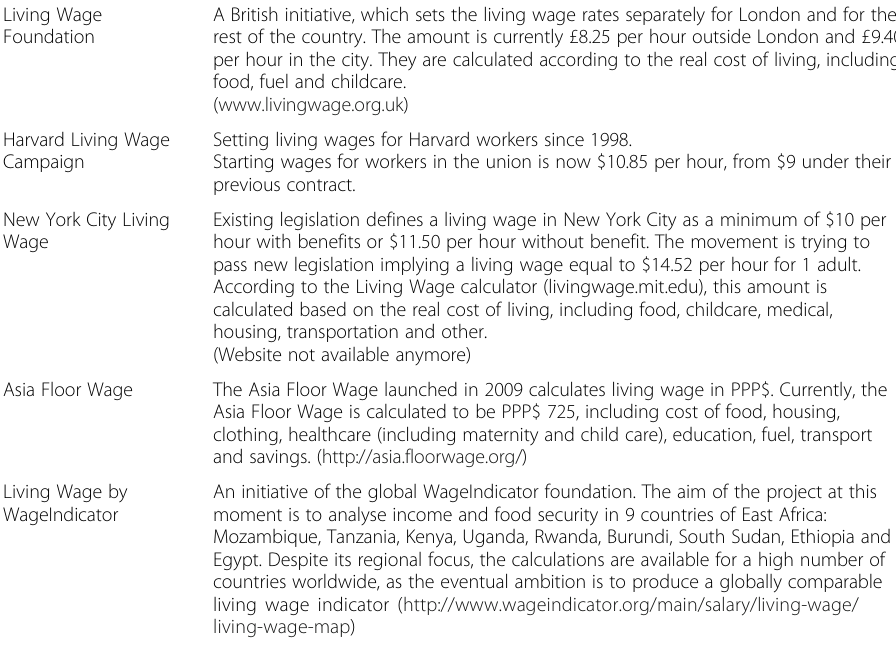
Table 1 Examples of well-known living wage movements Living Wage